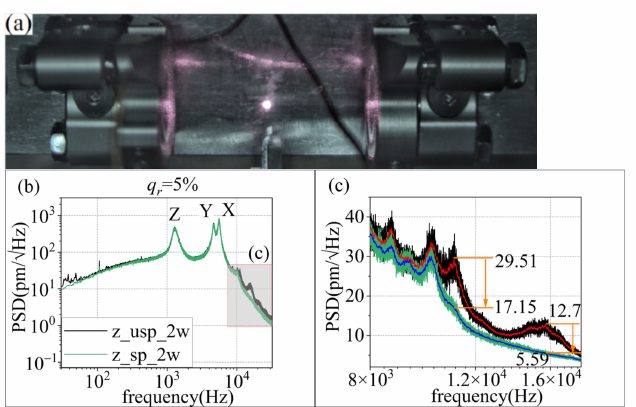
Figure 8. Suppression results of the PSD of center-of-mass displacement. ( a ) The captured particle. ( b ) The PSD after and before the 16.9 dB RIN suppression in the Z -axis. ( c ) Larger views of the areas of b.